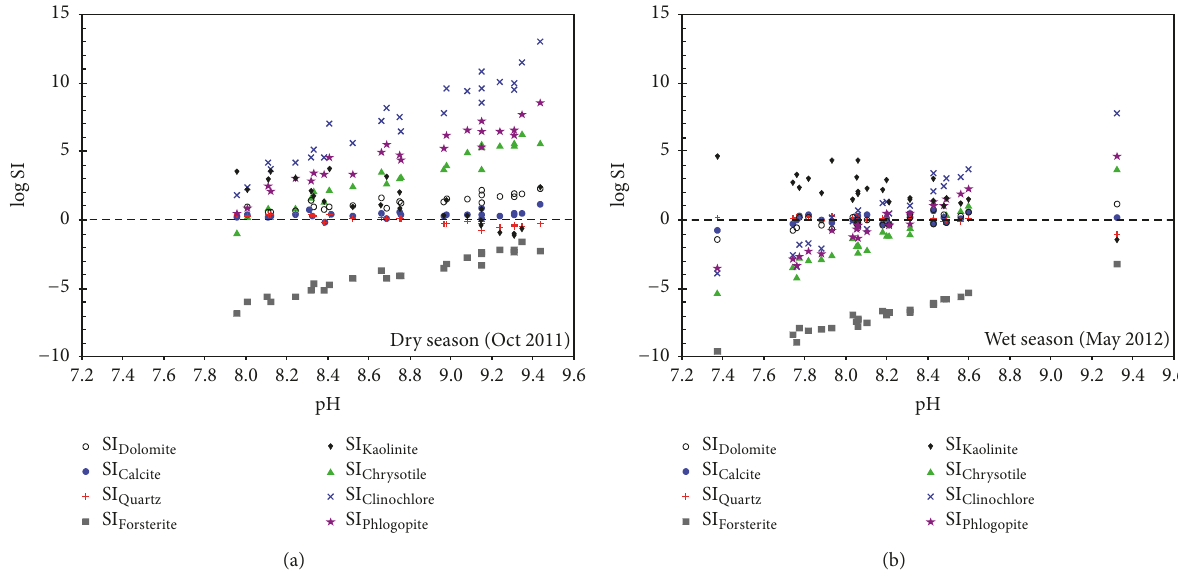
Figure 9: Saturation indices of the (a) dry season and (b) wet season groundwater samples with respect to various primary and secondary mineral phases. Saturation indices were calculated by the geochemical code PHREEQC Interactive ver. 3.1.4 [78] using the accompanying LLNL thermodynamic database